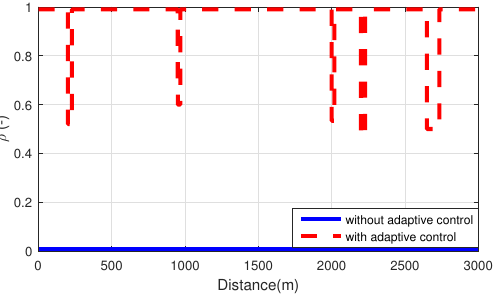
Figure 12. Scheduling